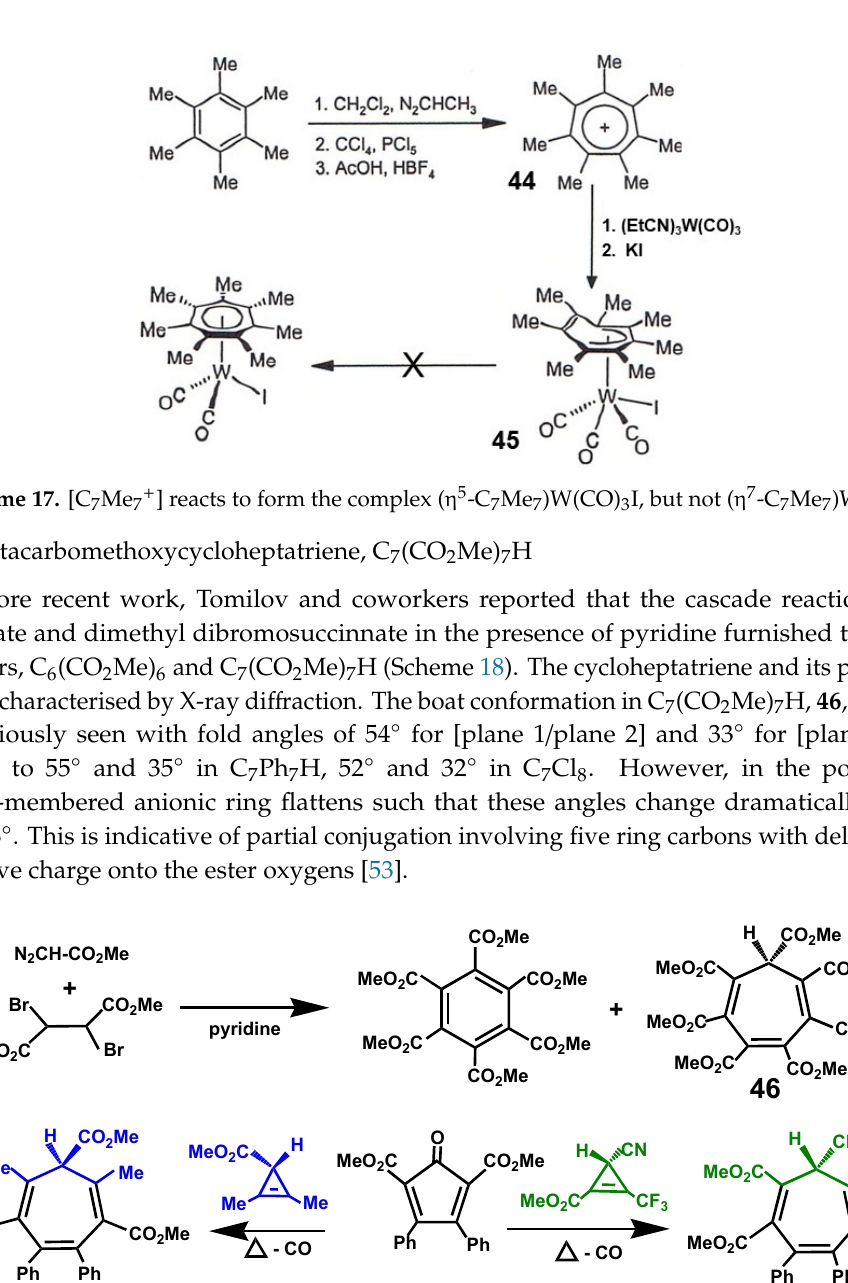
Scheme 18. Diels-Alder reactions of cyclopentadienones and cyclopropenes bearing multiple electron-withdrawing substituents.